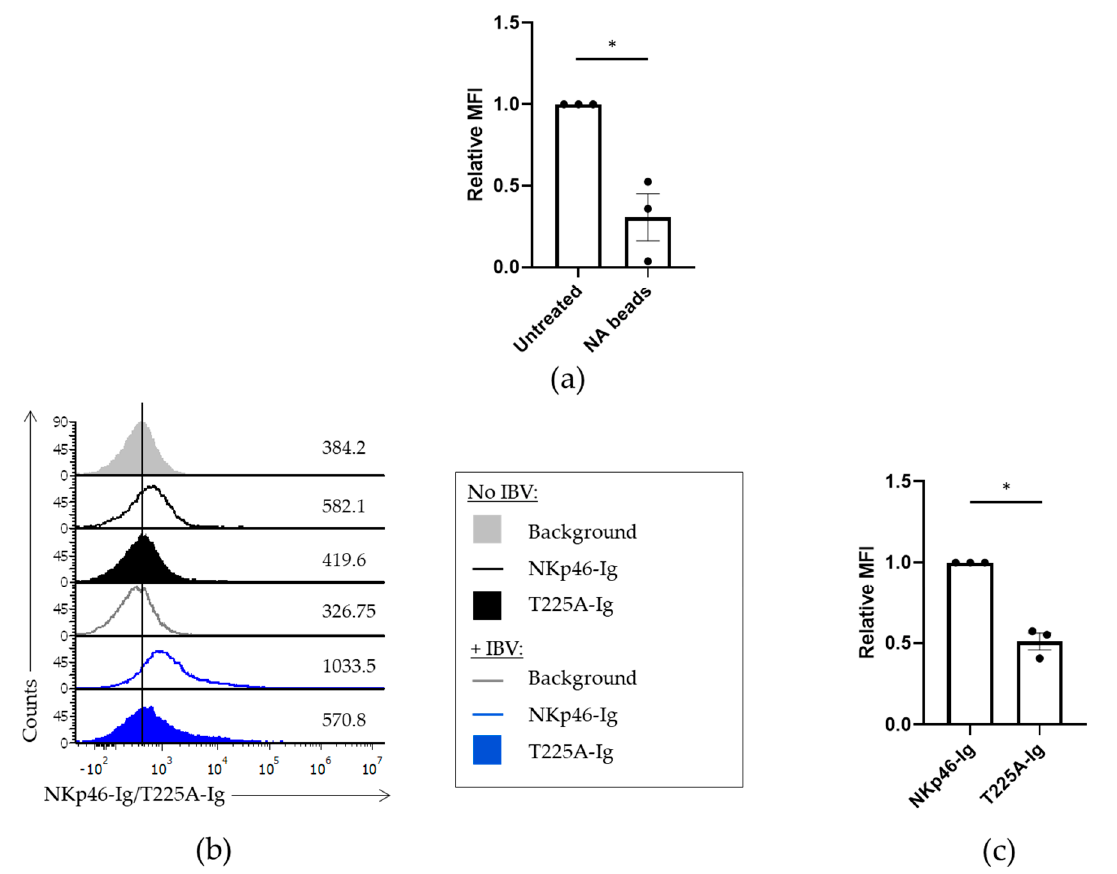
Figure 3. The binding of NKp46 to IBV is dependent on the sialic acid present on threonine 225. ( a ) NKp46-Ig fusion proteins were treated or not with Neuraminidase beads (NA beads) and then incubated with Jeg3 cells in the presence of IBV. The graphs summarize average of three independent experiments. The results were normalized to staining of the cells with untreated NKp46-Ig. Values are shown as mean ± SEM. * p < 0.05 by two-tailed paired Student’s t test. ( b ) Jeg3 incubated or not with IBV was stained with NKp46-Ig (No IBV = black histogram; +IBV = blue histogram) or the mutant NKp46 T225A-Ig (No IBV = black, filled histogram; +IBV = blue, filled histogram). The gray, filled histograms and gray, empty histograms represent the staining with secondary antibodies only in the absence or presence of influenza, respectively. Figure shows one representative experiment out of three performed. ( c ) MFI quantification of three independent experiments including data presented in ( b ). FACS staining with T225A-Ig against IBV was normalized to the staining of the cells with NKp46-Ig. Values are shown as mean ± SEM. * p < 0.05 by two-tailed paired Student’s t test.